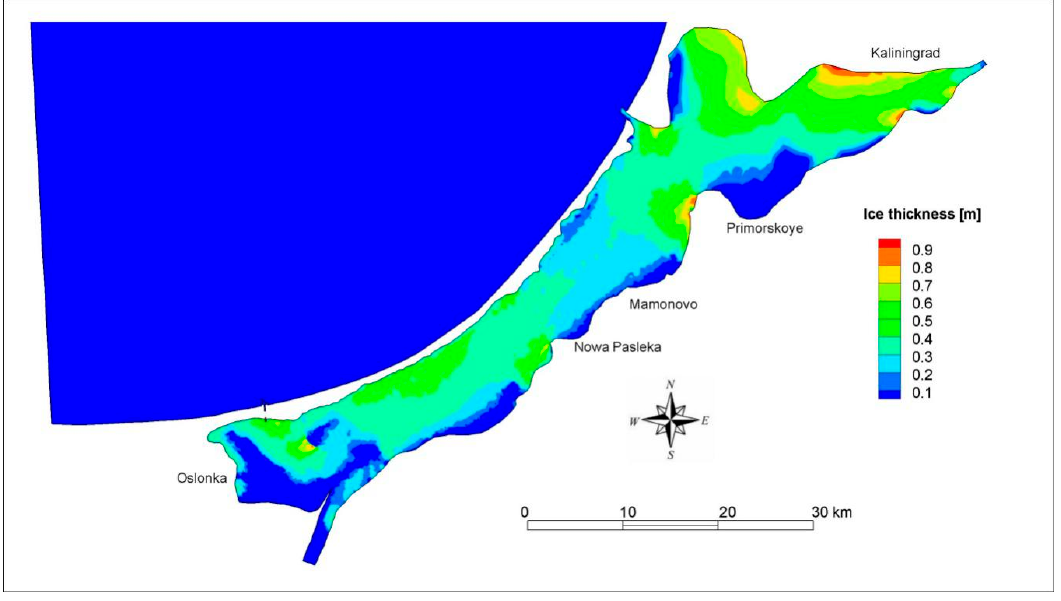
Figure 11. Simulation results of the ice thickness for a wind blowing from a South-West direction.